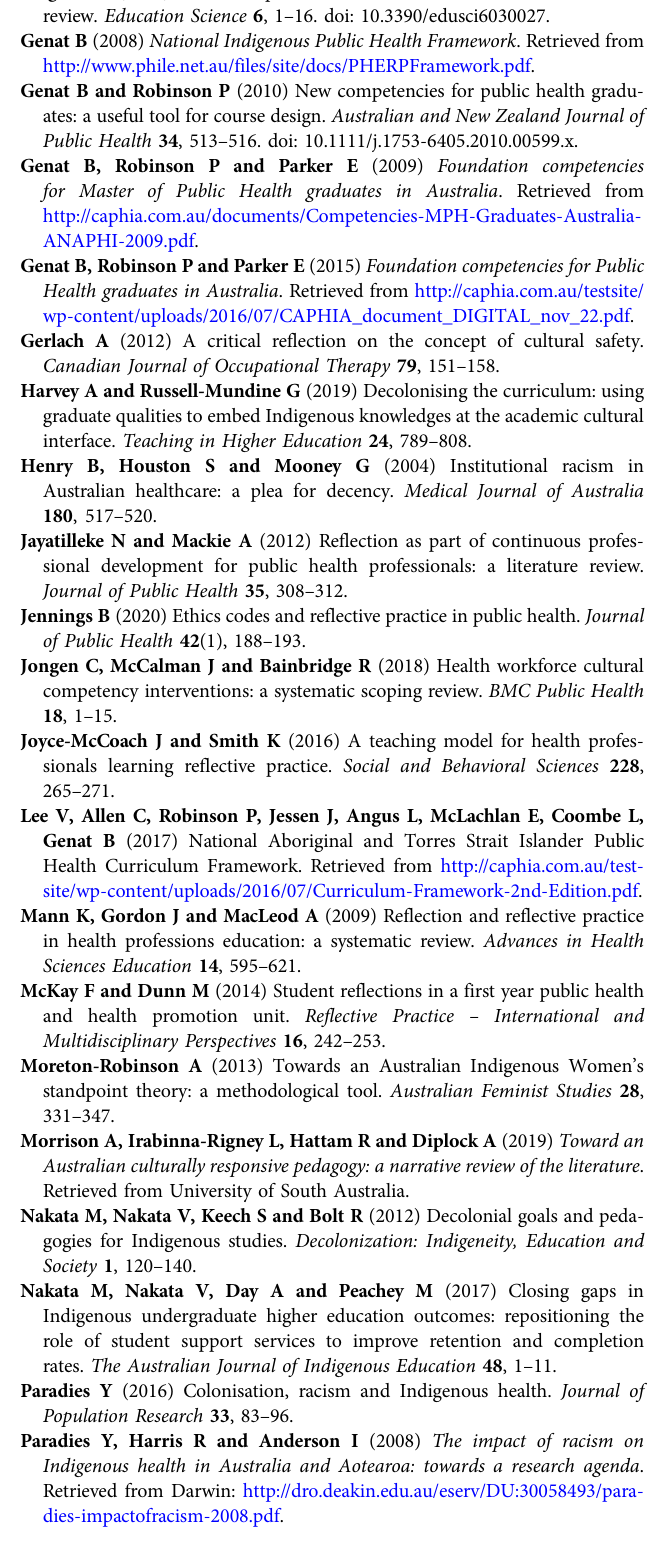
figure power relationships between Indigenous